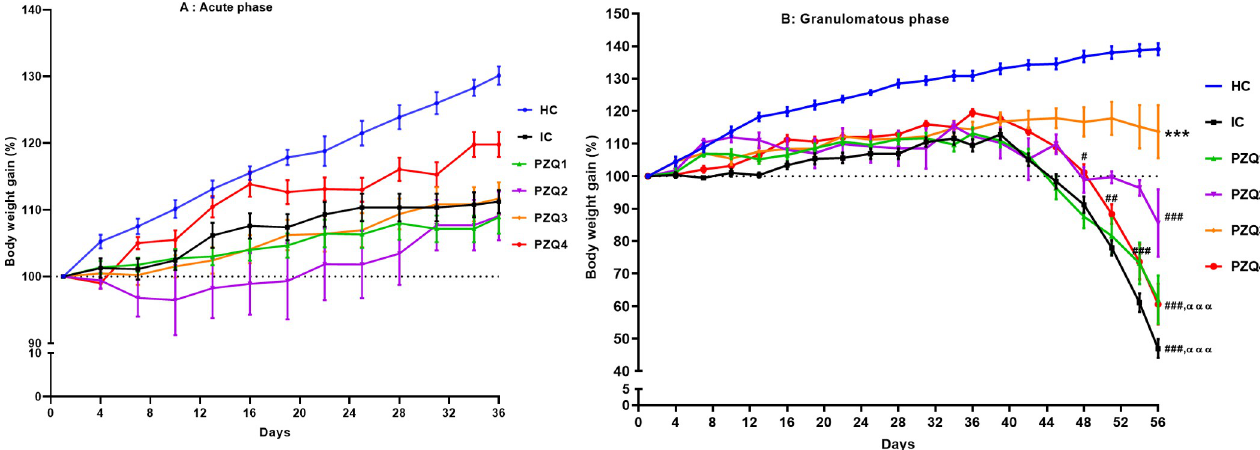
Fig 2. Effect of praziquantel treatment on the body weight during acute (A) and granulomatous (B) stages of Schistosoma mansoni infection in mice. HC: Uninfected mice, IC: Infected-untreated mice, PZQ1: Infected mice treated with praziquantel at 100 mg/kg for 5 consecutive days, PZQ2: Infected mice treated with praziquantel at 100 mg/kg for 28 consecutive days, PZQ3: Infected mice treated with praziquantel at 18 mg/kg for 28 consecutive days, PZQ4: Infected mice treated with a single dose of praziquantel at 500 mg/kg. Data are expressed as mean ± SEM (n = 6). ANOVA followed by Tukey multiple comparison test was also used for statistical analysis. # p < 0.05, ## p < 0.01, ### p < 0.001: values are significantly different from those of uninfected mice (group HC). ��� p < 0.001: values are significantly different from those of infected-untreated mice (group IC). ααα p < 0.001: values are significantly different from those of infected mice treated with PZQ3 posology (group